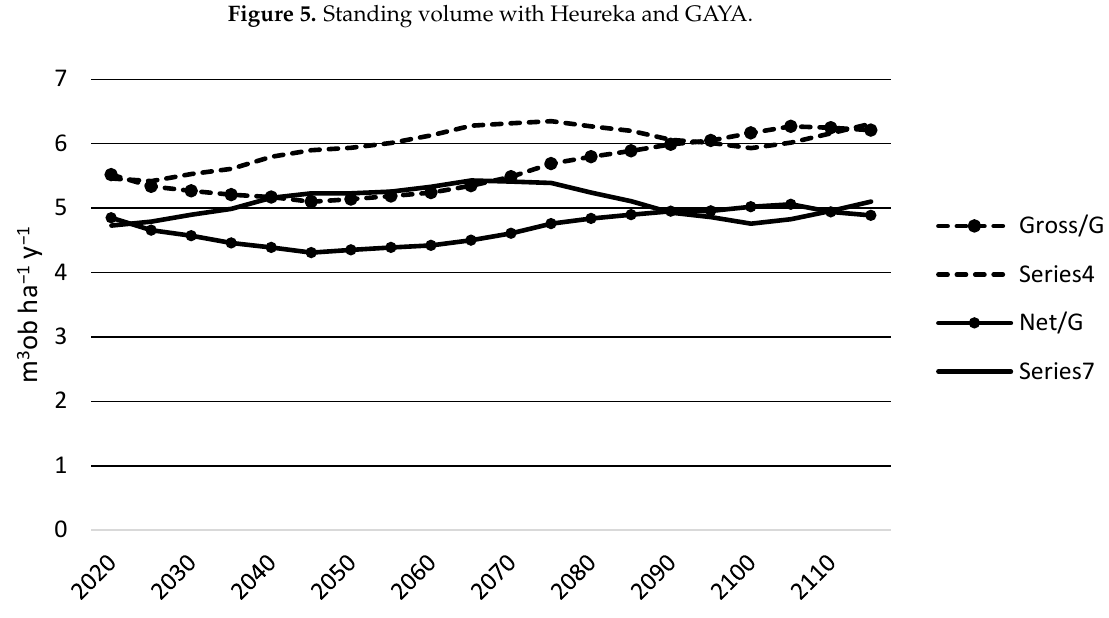
Figure 5. Standing volume with Heureka and GAYA.